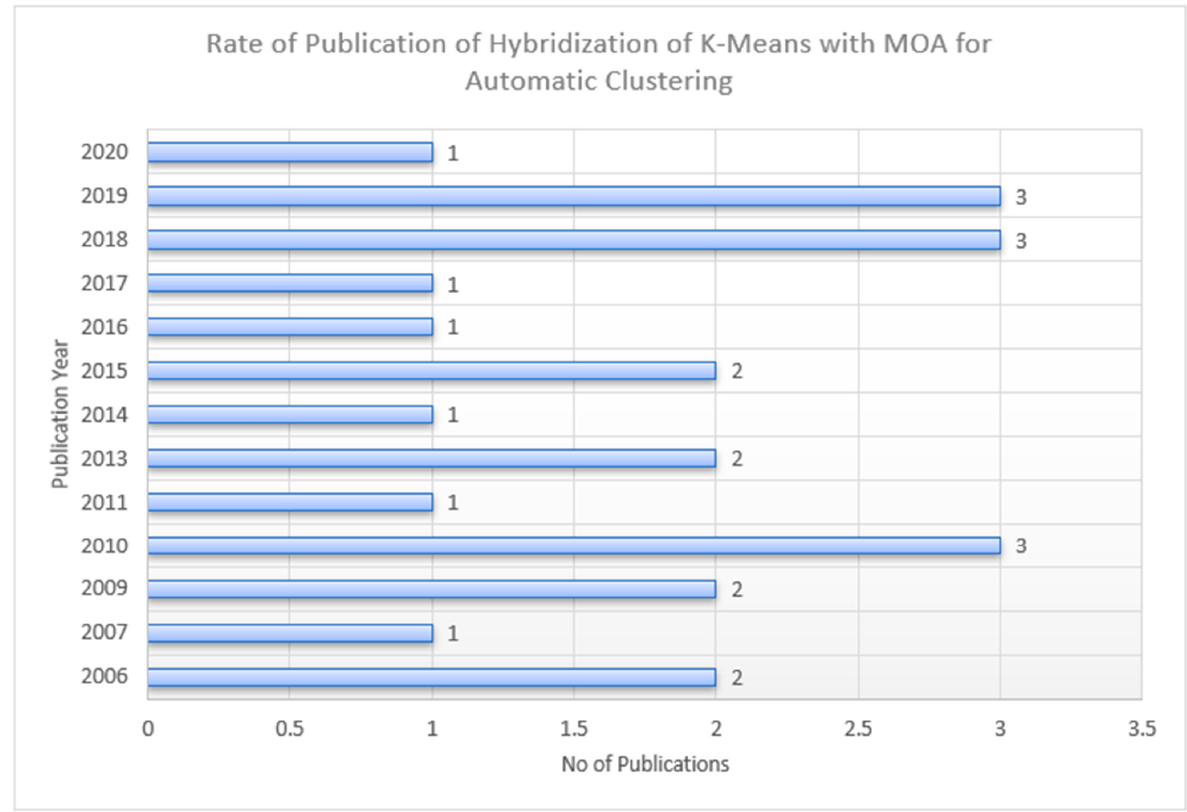
Figure 3. Publication rate of K-means hybridization with MOA for automatic clustering.